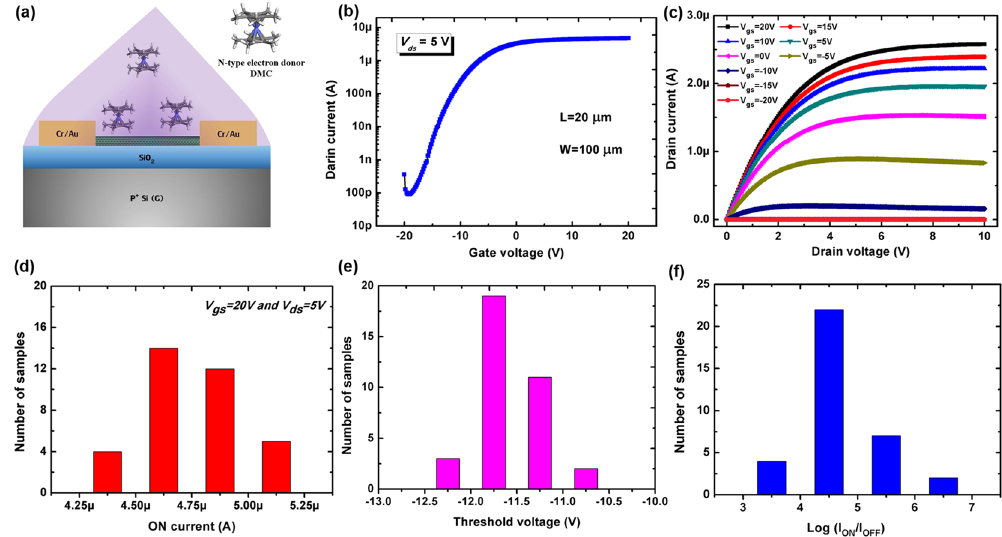
Figure 2. Structural and electrical characterization of back-gated CNFETs after DMC n-doping. ( a ) The schematic of the CNFET device coated with a DMC layer and the molecular structure of DMC with cobalt atom (blue), carbon atoms (gray) and hydrogen atoms (white). ( b ) Transfer curves and ( c ) output characteristics of a doped CNFET device after 5.0 wt.% with W/L = 100 μ m/20 μ m. Distribution of ( d ) I on current at V gs = 20 V and V ds = 5 V, ( e ) threshold voltage and ( f ) I on / I off current ratio of 35 n-type doped CNFET